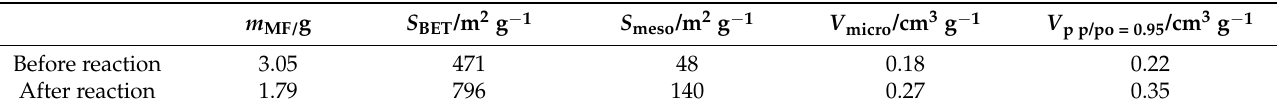
Figure 9. NO concentration in a stability assay at 300 ◦ C for 75 h. Table 4 indicates the textural properties before and after the stability test. Table 4. Textural properties of the MF_U_30Cu before and after the stability